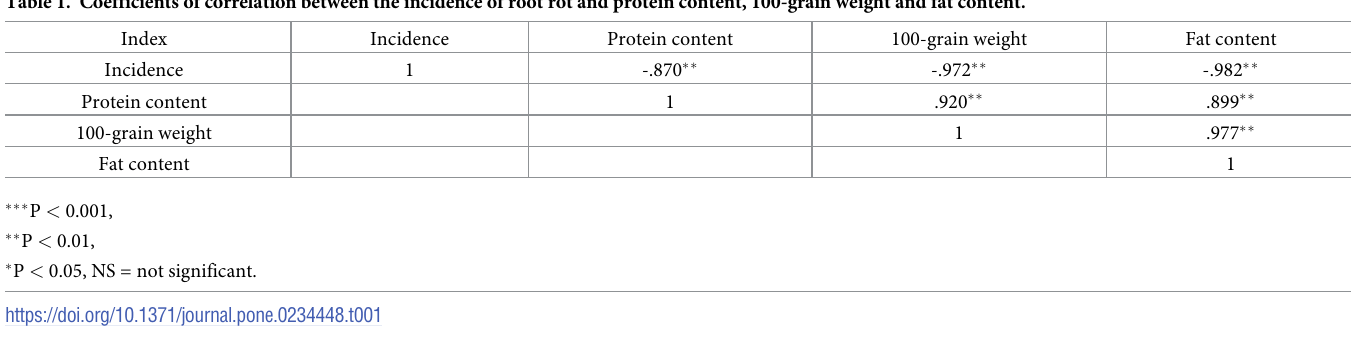
group was different.